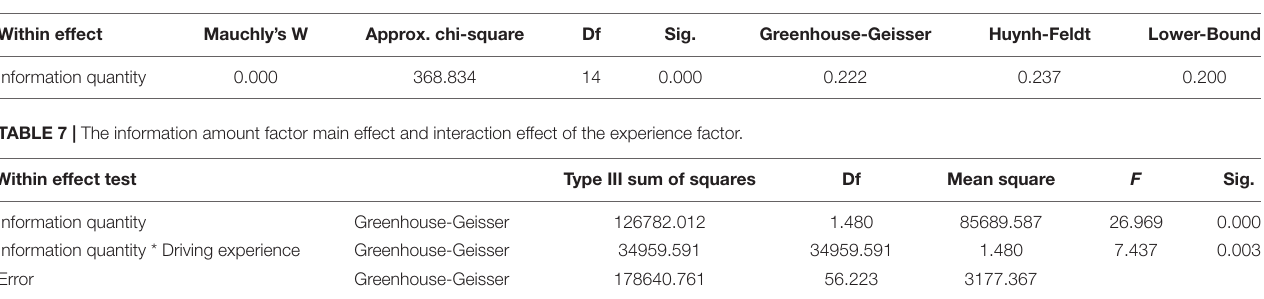
TABLE 6 | Mauchly’s test of sphericity.